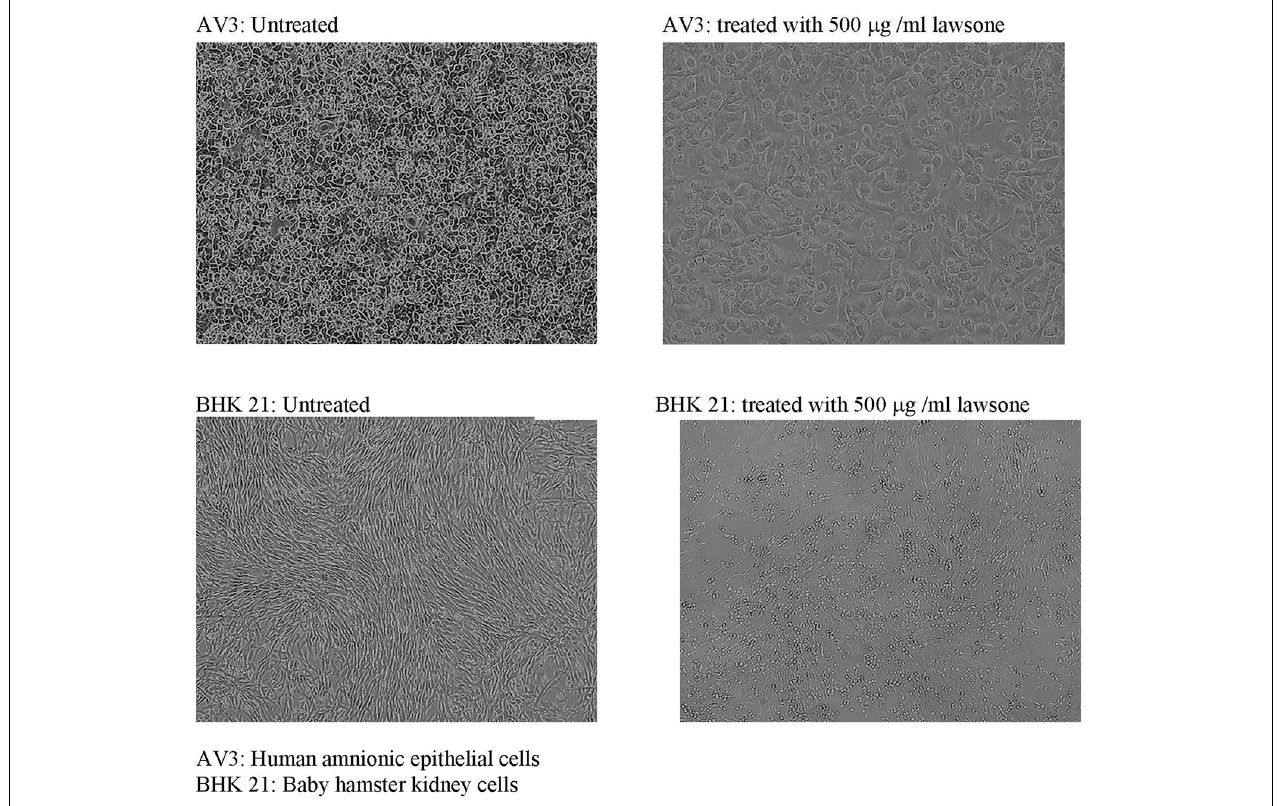
FIGURE 3 | Toxicity testing of lawsone on AV3 and BHK 21 cell lines. AV3, human amnionic epithelial cells; BHK 21, baby hamster kidney cells.